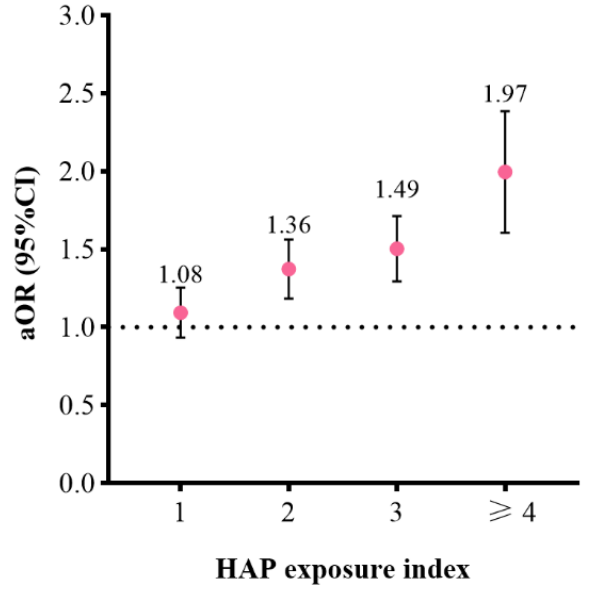
Figure 1. The accumulative effect of prenatal exposure to HAP on PTB. HAP exposure index: how many household air pollution sources the mother was exposed to during pregnancy; aOR: adjusted for child’s sex, maternal age at delivery, maternal educational level, family income, marital status, parity and pre-pregnancy BMI.